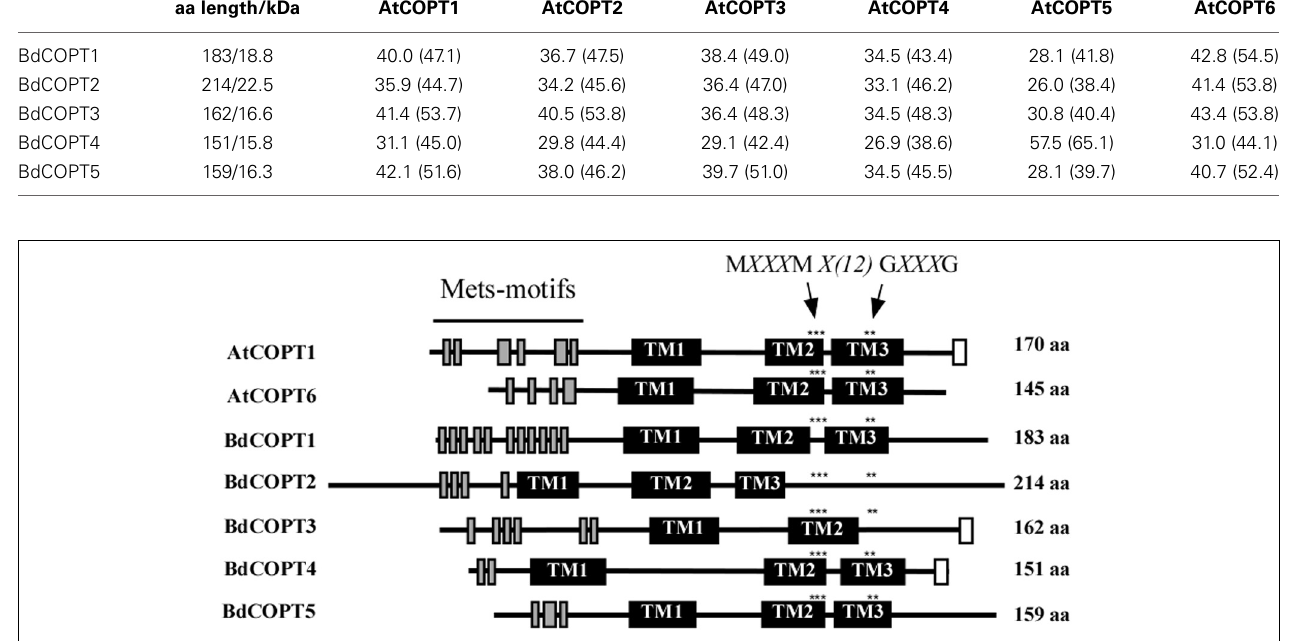
FIGURE 2 | A diagram showing conserved motifs within the primary sequence of BdCOPT proteins and their homologs in A. thaliana, AtCOPT1 and AtCOPT6. Topology predictions are based on the TMHMM software, version 1.0. Shown are methionine-rich motifs within the predicted N-terminal domain (Mets-motifs, gray bars), transmembrane domains (TM1,